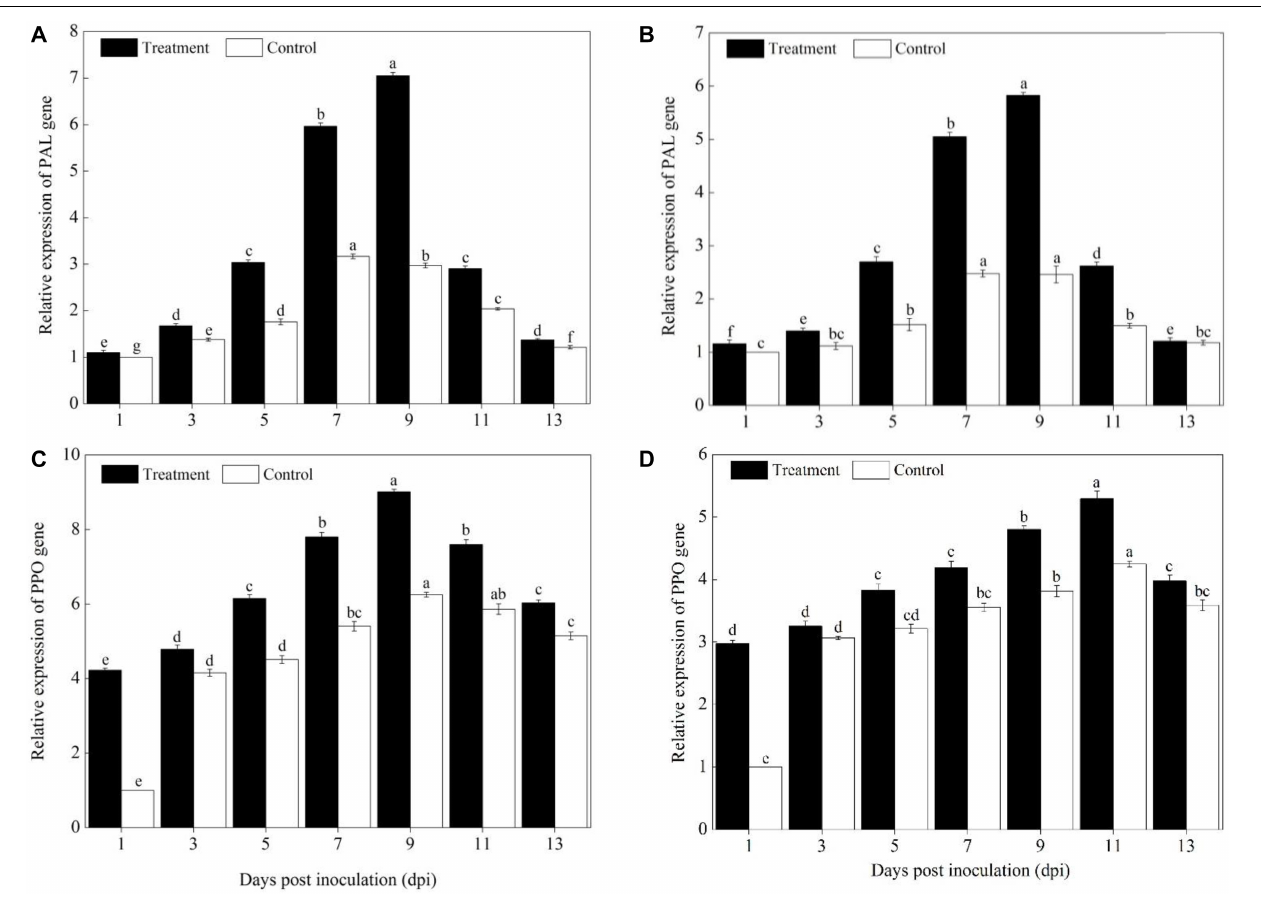
FIGURE 4 | Expression levels of PAL and PPO genes in the leaves of Sixing F 1 and Jin 12 F 1 at different time points after being inoculated with Podosphaera xanthii. (A,B) The expression levels of the PAL gene in Sixing F 1 and Jin 12 F 1 , respectively; (C,D) the expression levels of the PPO gene in Sixing F 1 and Jin 12 F 1 , respectively. The line bars, different letters, and treatments are detailed in the footnote of Figure 2 and Table 2